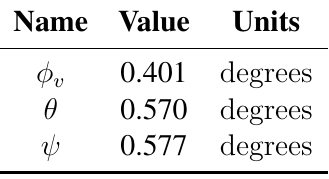
Table 5. Root mean square error for cascaded EKF attitude estimates.